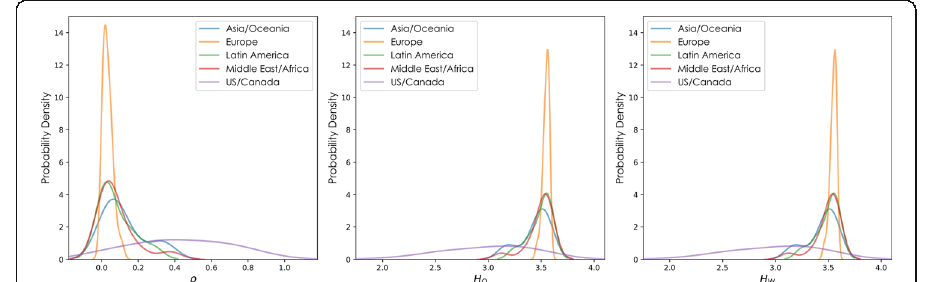
Fig. 1 Probability densities of cities ’ φ , Η o , and Η w , by region, estimated with kernel density estimation. The area under each curve equals